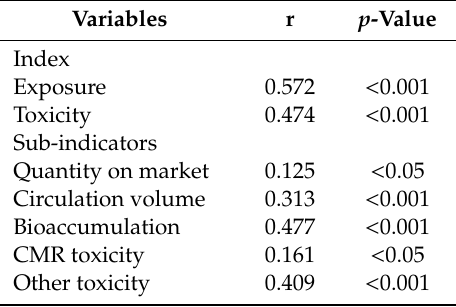
Table 6. Correlation coe ffi cients (r) from linear regression analysis for the e ff ect of index and sub-indicators on total score.